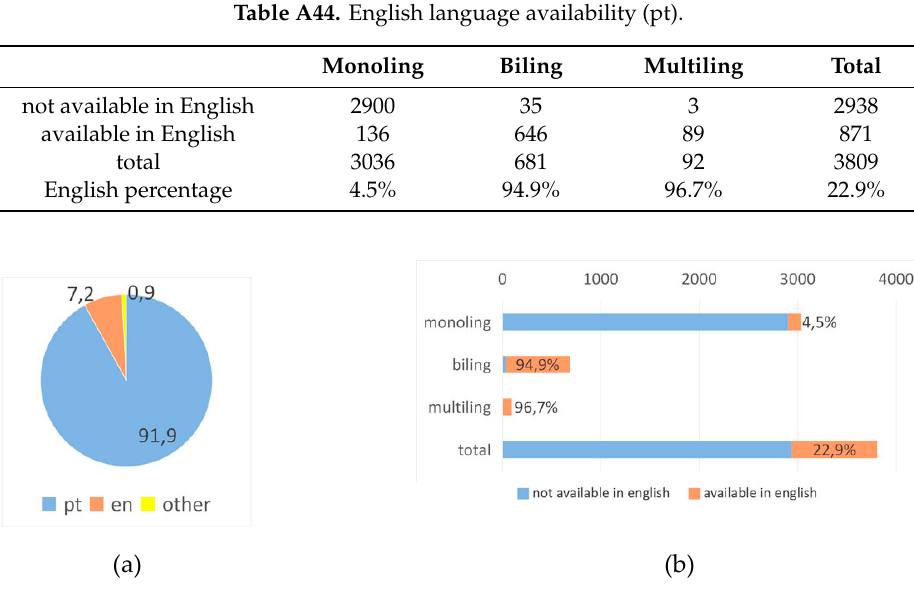
Figure A22. Visualization of the results for domain pt. ( a ) Primary languages pie chart and ( b ) English language availability bar chart.